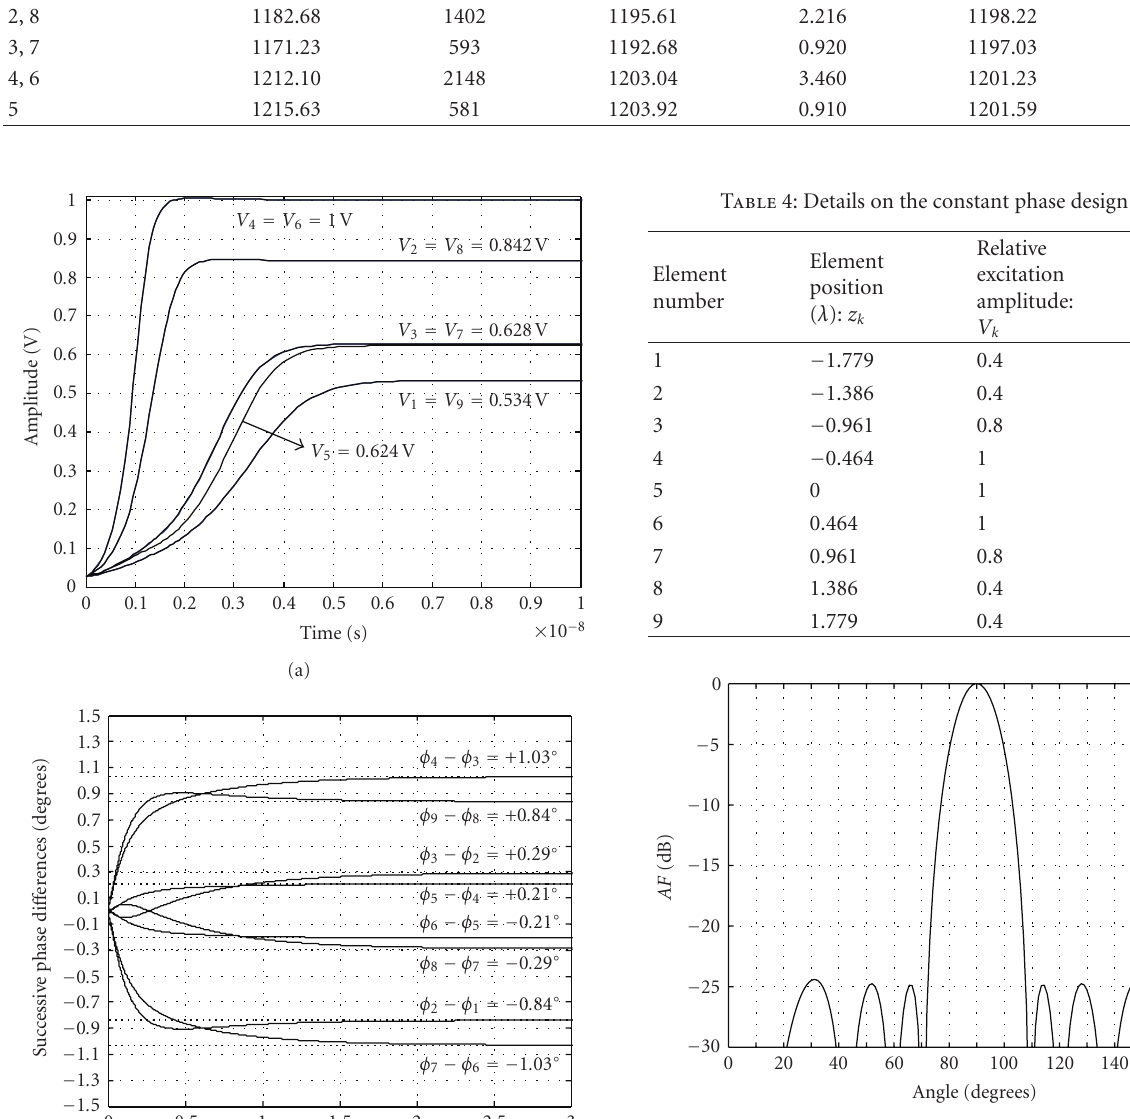
Figure 6: The attained pattern for the constant phase design